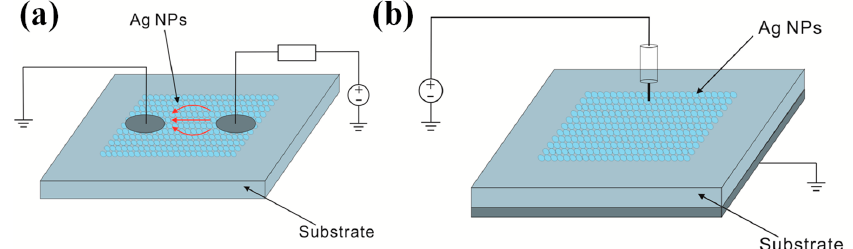
Figure 12. ( a ) schematic illustration of a contact-mode Direct current (DC) electrical sintering setup and ( b ) contactless Alternating current (AC) sintering between a probe above the NPs layer and a ground plate beneath the printing